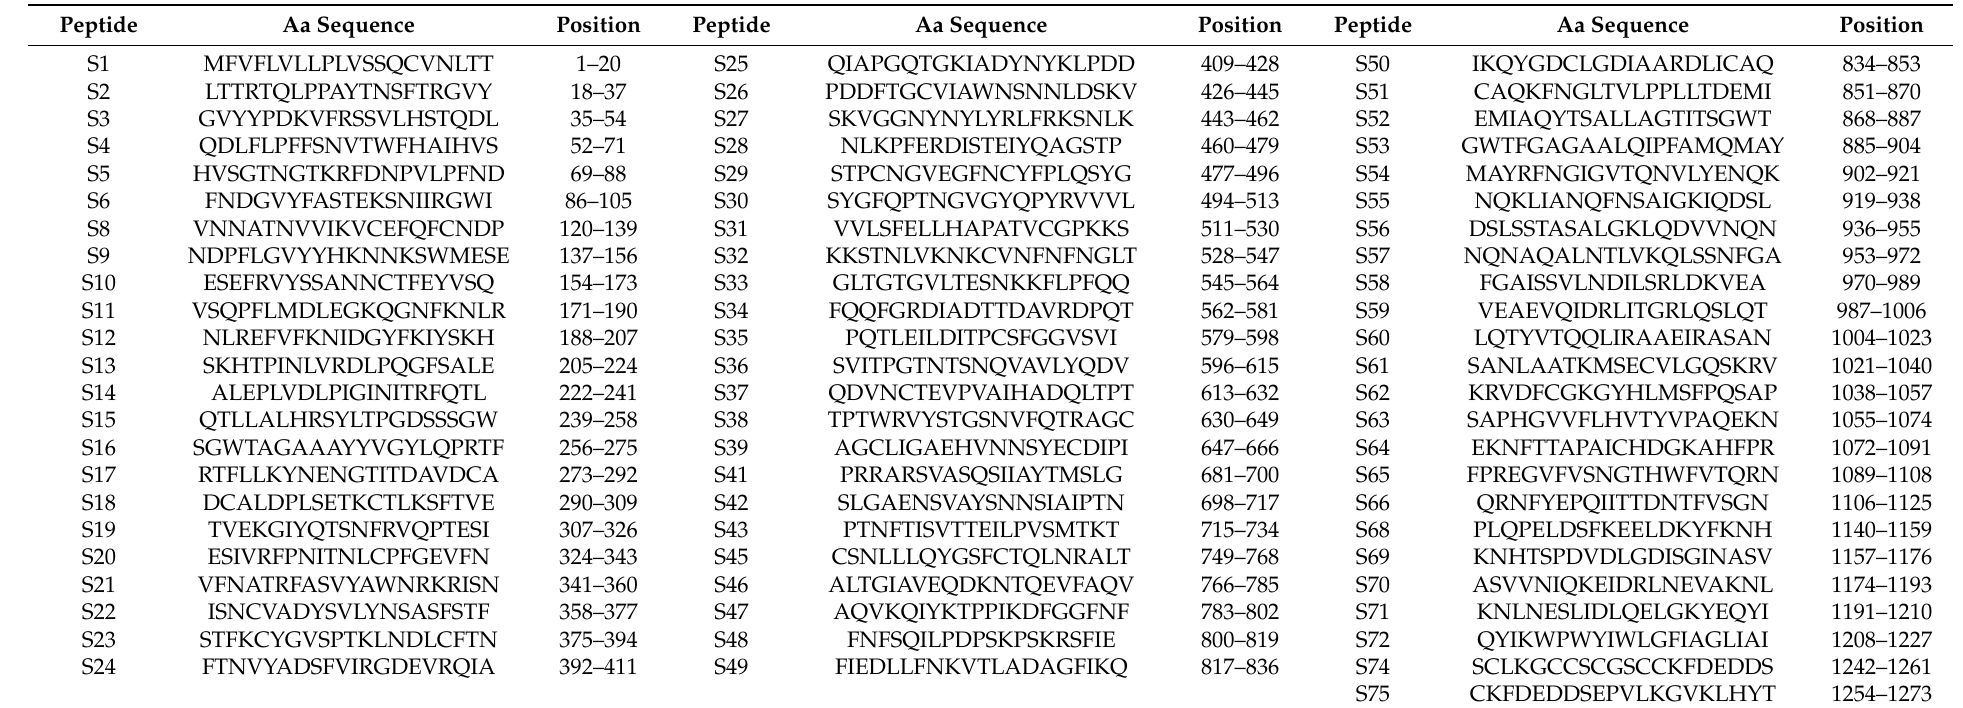
Table 5. Sequence and position of SARS-CoV-2 S protein